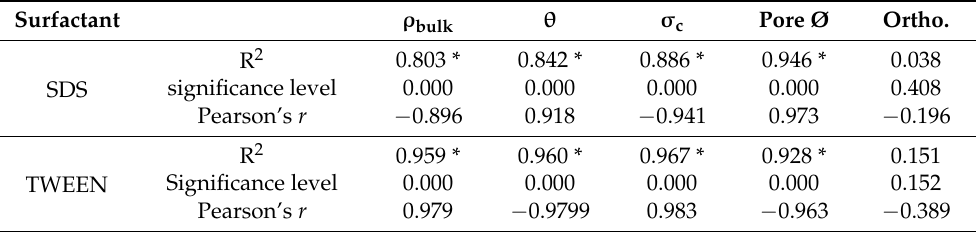
Table 2. Coefficient of determination R 2 , significance level and Pearson’s r from linear regression analysis.